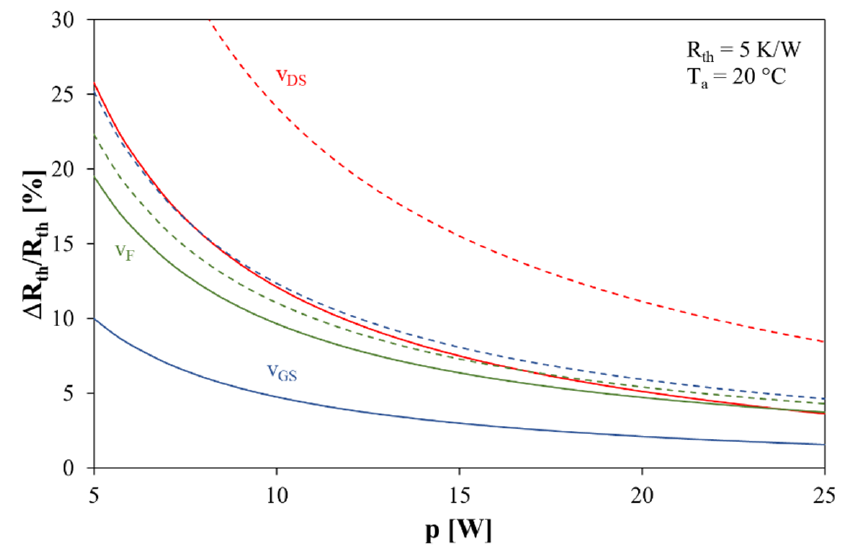
Figure 10. Dependence of the relative measurement error of thermal resistance of transistor M 1 on the power that is dissipated in this transistor.